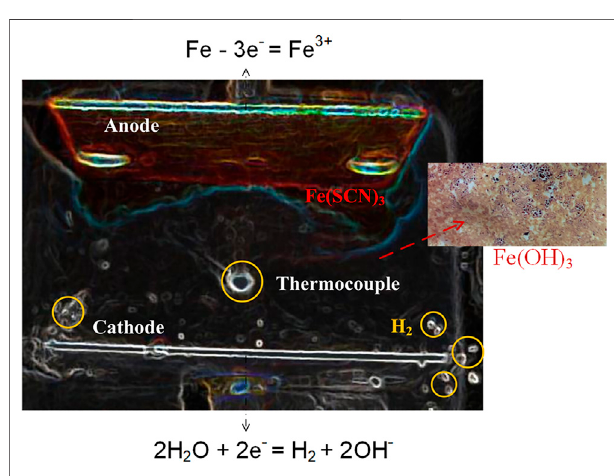
FIGURE 4 | The phenomenon of bipolar plate dropping KSCN solution into